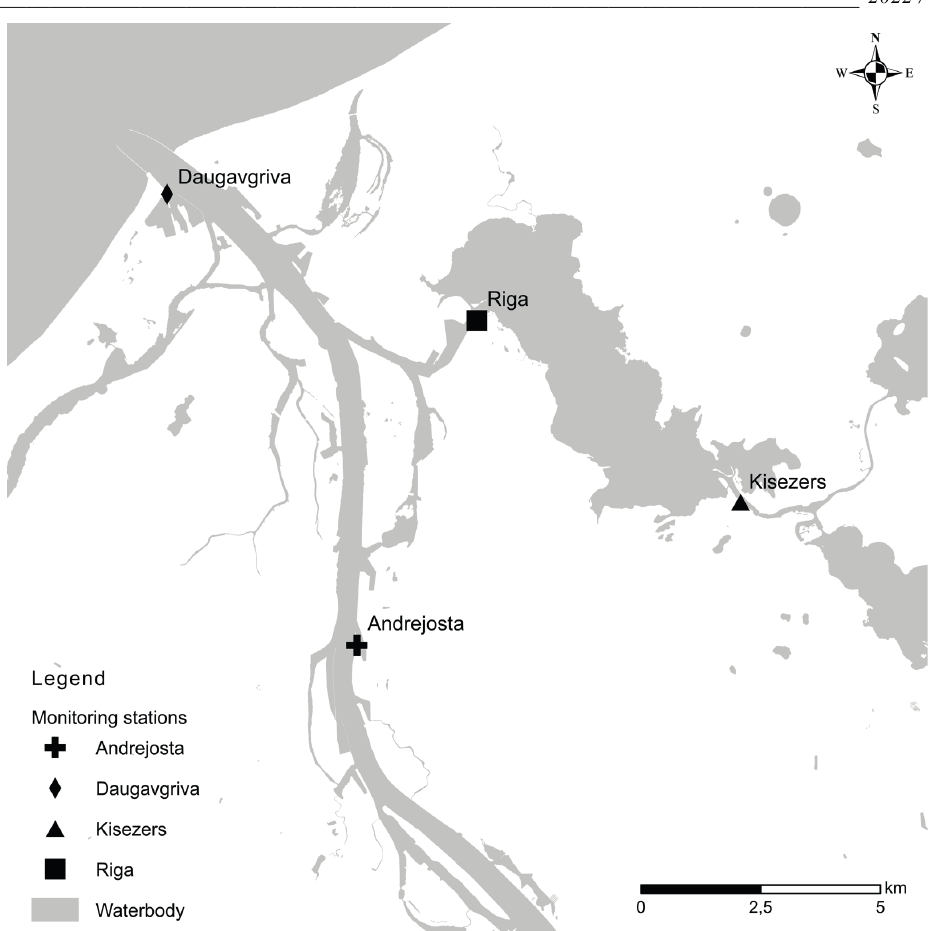
Fig. 1. Location of the study area and monitoring